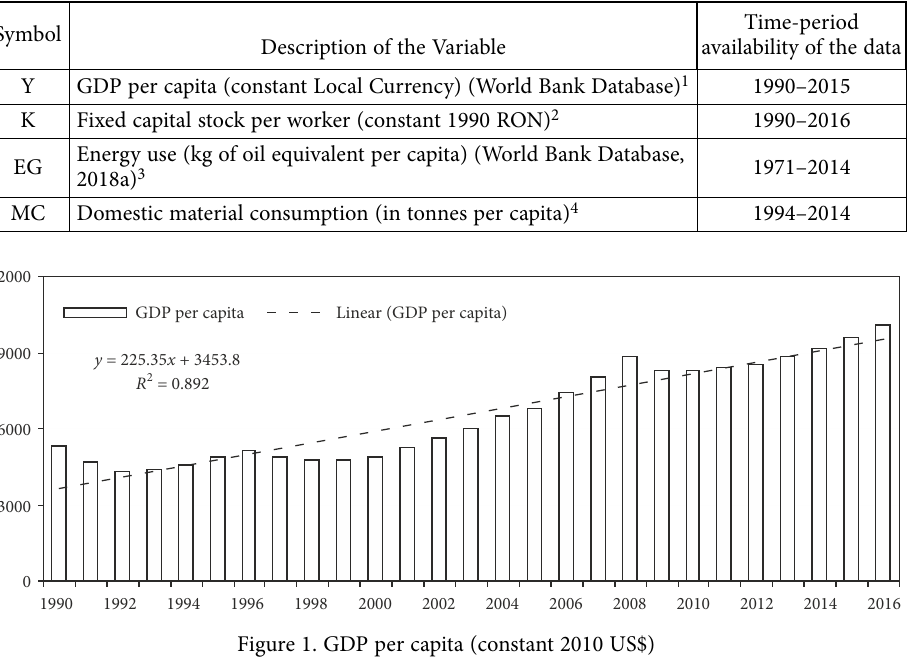
Table 1. Data series and sources (source: authors based on Eurostat, 2018; ILO, 2018; NIS, 2018; World Bank Database, 2018a, 2018b) Symbol